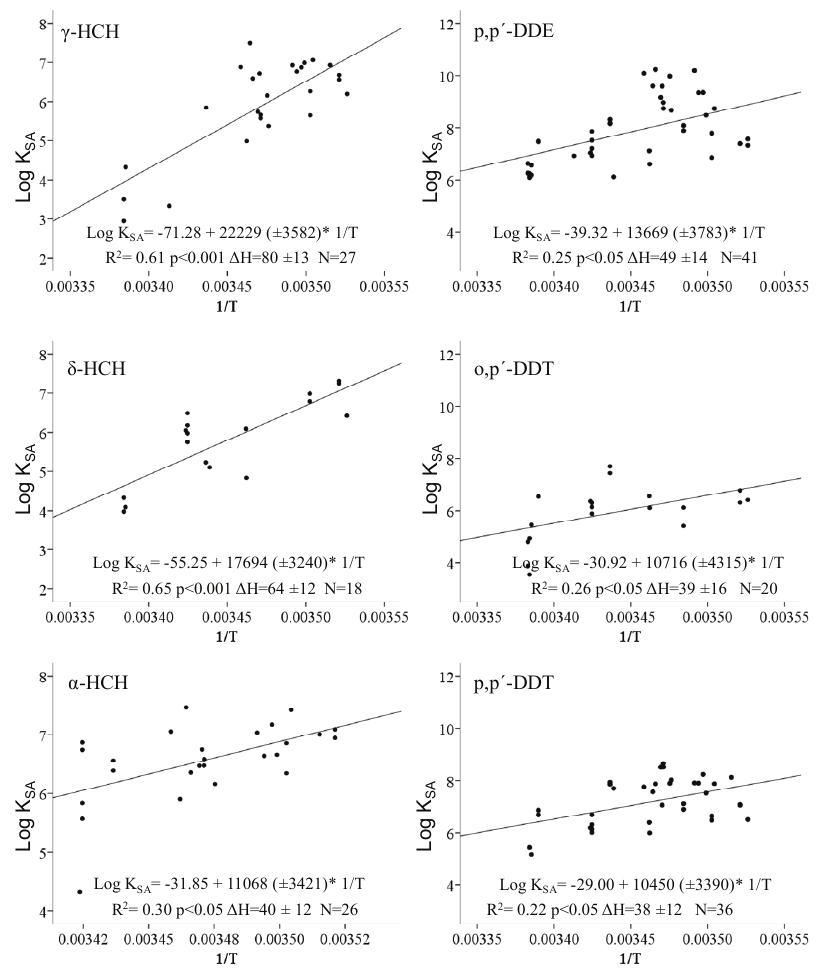
Fig. 3. Regression of soil-air partition coefficient (Log K SA ) versus temperature (1/ T ) for selected HCH isomers and DDT metabolites. apparent negative enthalpies of volatilization. Then, it is pos- sible that the enthalpy of volatilization from the pure com- pound is similar to the enthalpy of solubilization to SOM in the case of HCB. These suggest that HCB is weakly tempera- ture dependent and other processes are strongly affecting the partitioning behavior, consistent with the lack of temperature dependence of its K SA in this study and other